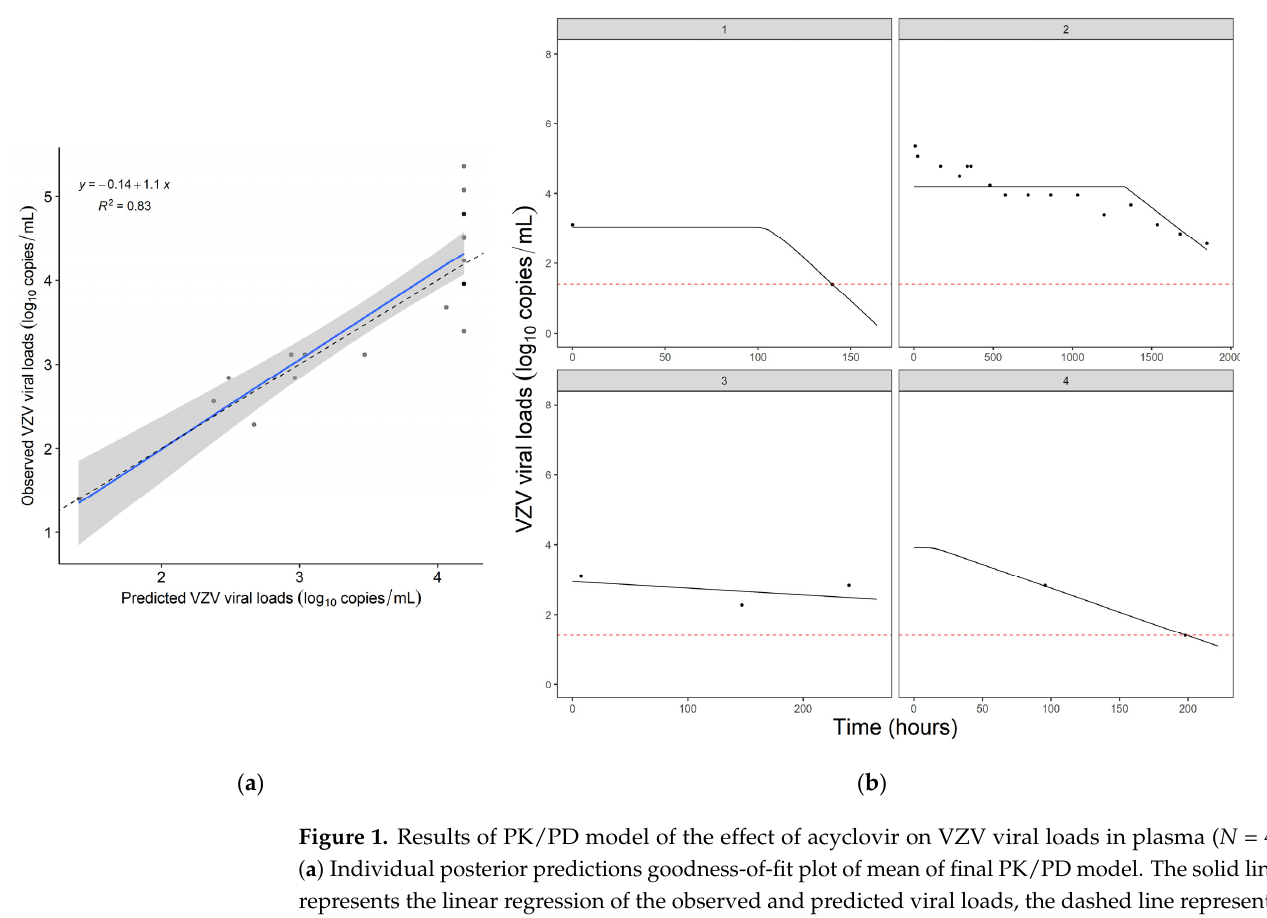
Figure 1. Results of PK/PD model of the effect of acyclovir on VZV viral loads in plasma ( N = 4) ( a ) Individual posterior predictions goodness-of-fit plot of mean of final PK/PD model. The solid line represents the linear regression of the observed and predicted viral loads, the dashed line represents a reference line for y = x and the black dots display the observed VZV viral loads ( b ) Individual VZV viral load (log 10 copies/mL) vs. time (hours) plots. The black dots represent the observed viral loads, the black line displays the individual predicted plot and the dotted line is the limit of detection. PK: